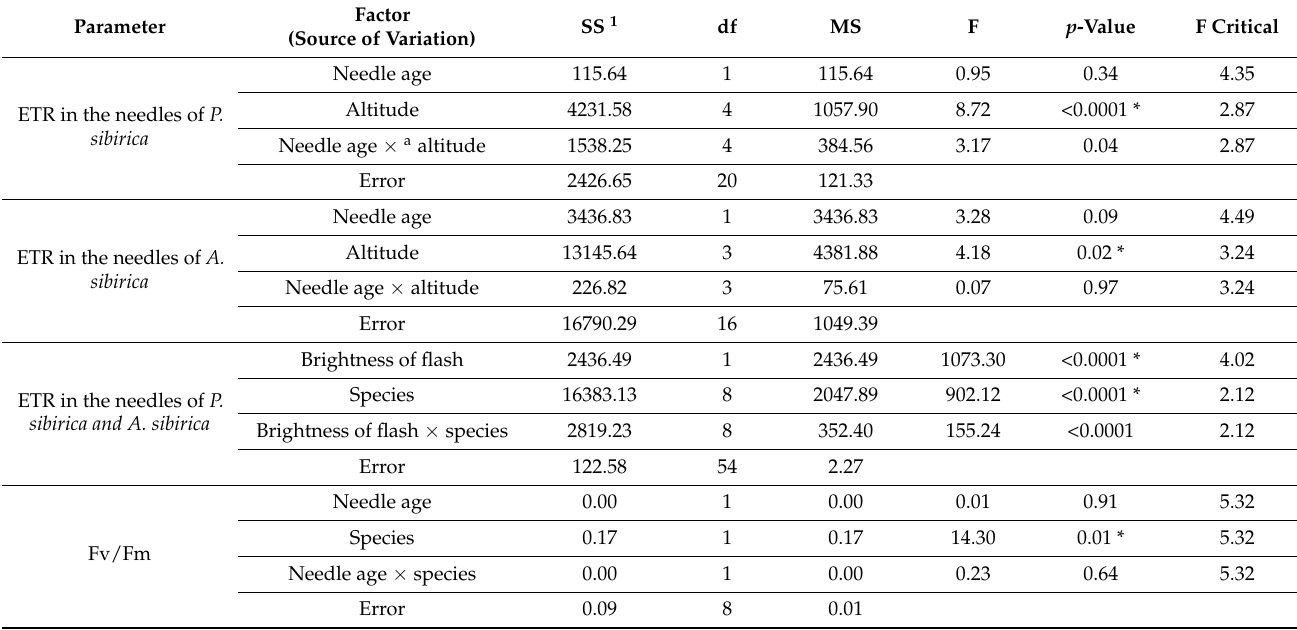
Table A1. Two-way ANOVA results on the influence of needle age PAR (brightness of flash of PAM-fluorimeter), and altitude a.s.l. on fluorescence in needle cells in P. sibirica and A. sibirica . Parameter